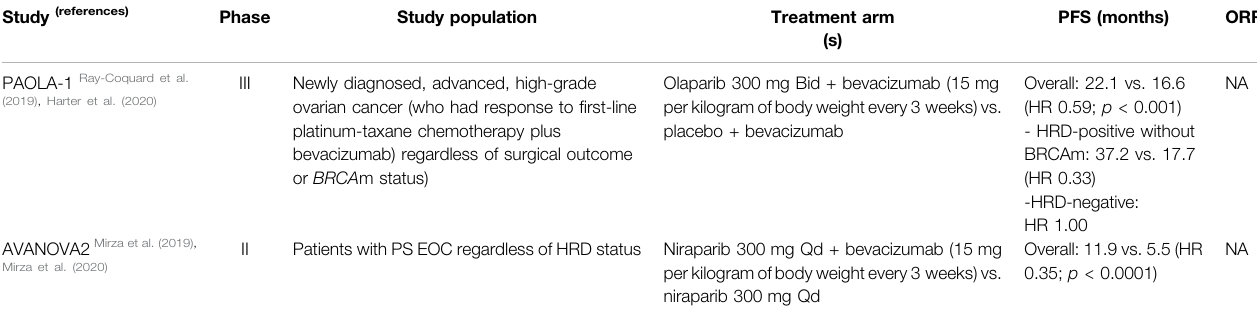
TABLE 3 | Published results for selected key studies of combination therapy to overcome resistance to PARP